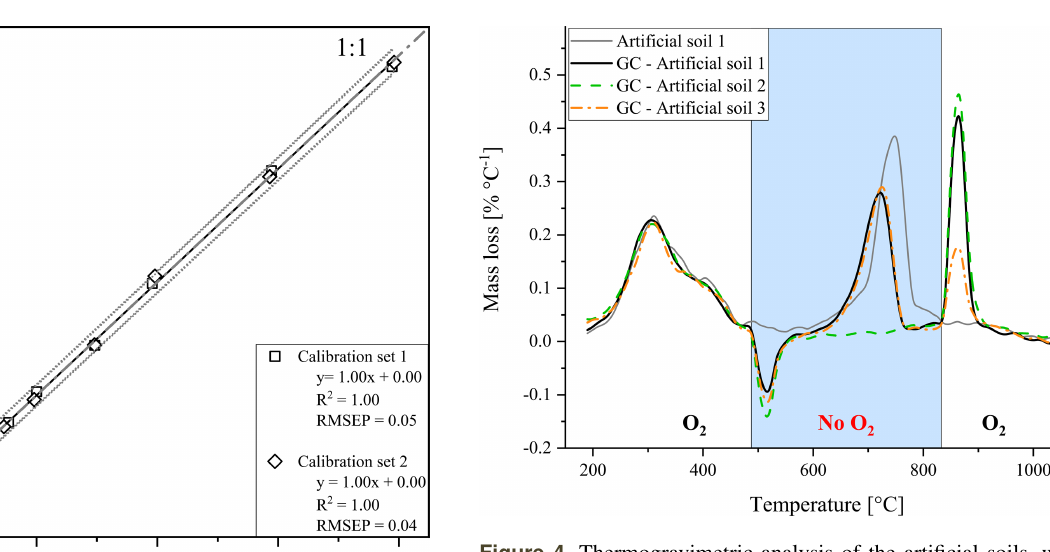
Figure 4. Thermogravimetric analysis of the artificial soils, with one lacking either carbonate (artificial soil 2, green) or graphite (ar- tificial soil 3, orange), whereby the oxygen gas supply was cut off during part of the standard heating program (GC – gas change). For comparison the artificial soil 1 under the normal program (without gas change) is also displayed in